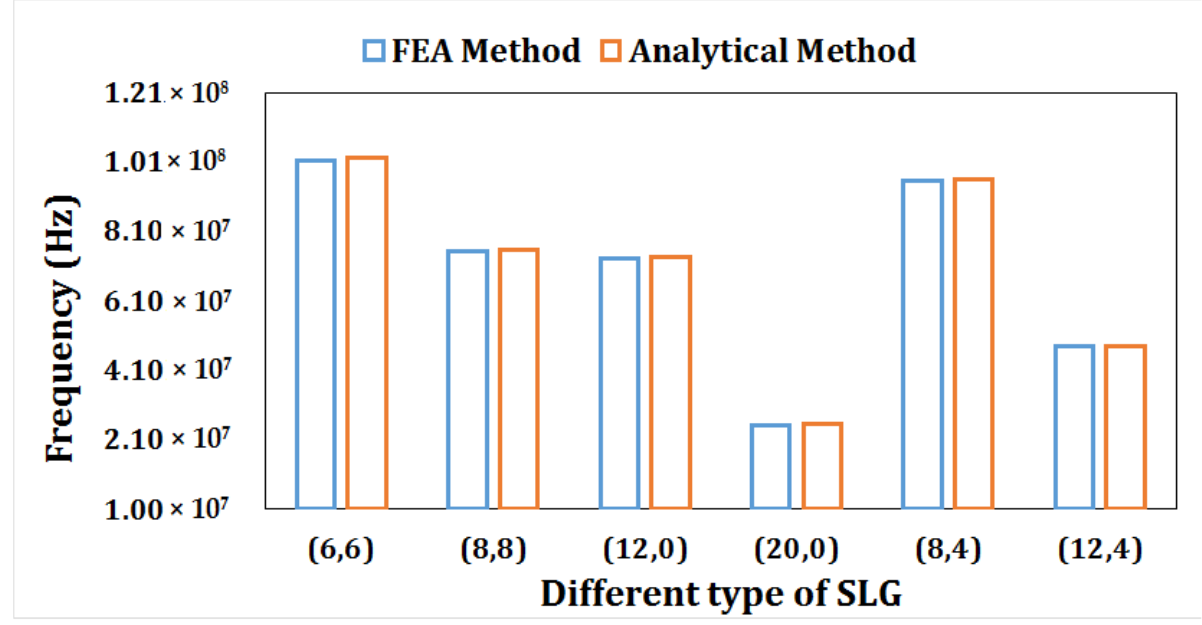
Figure 4. Compression of first mode of frequency of current FEA model and analytical model of Natsuki [50].